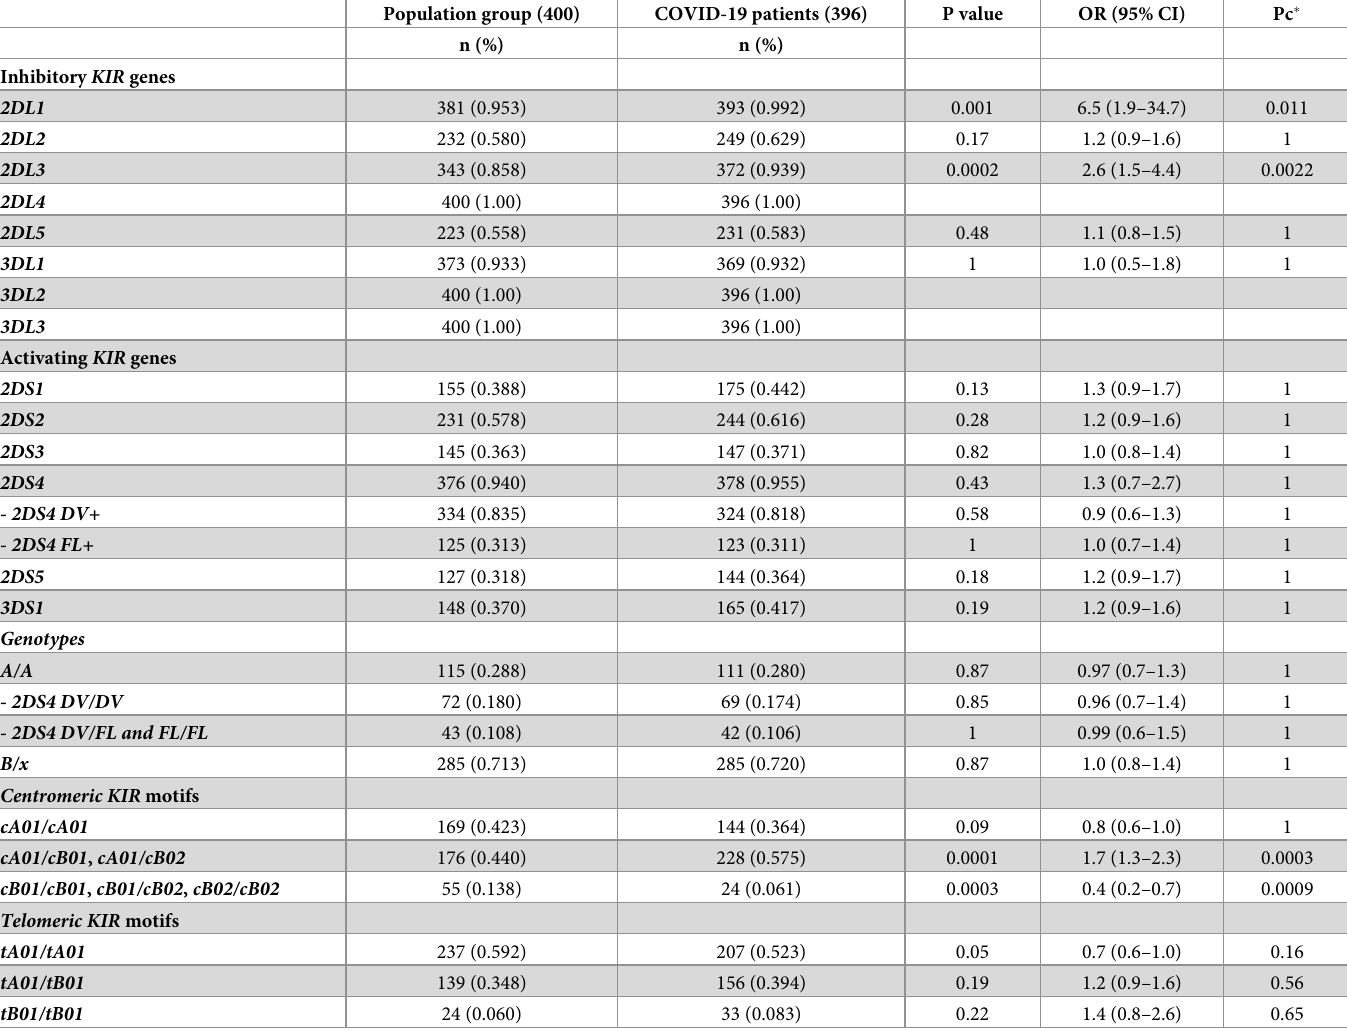
Table 2. KIR genes and genotype frequencies compared between patients and the population